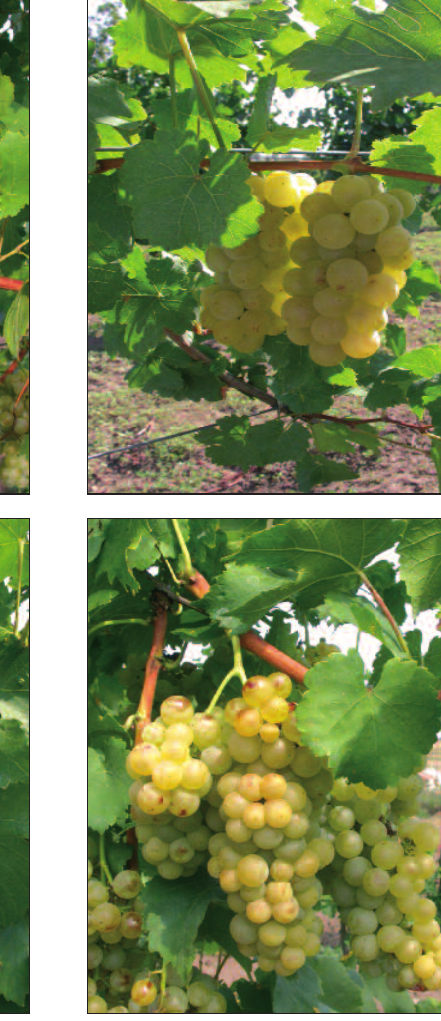
Fig. 15. Cluster types of Muscat ottonel